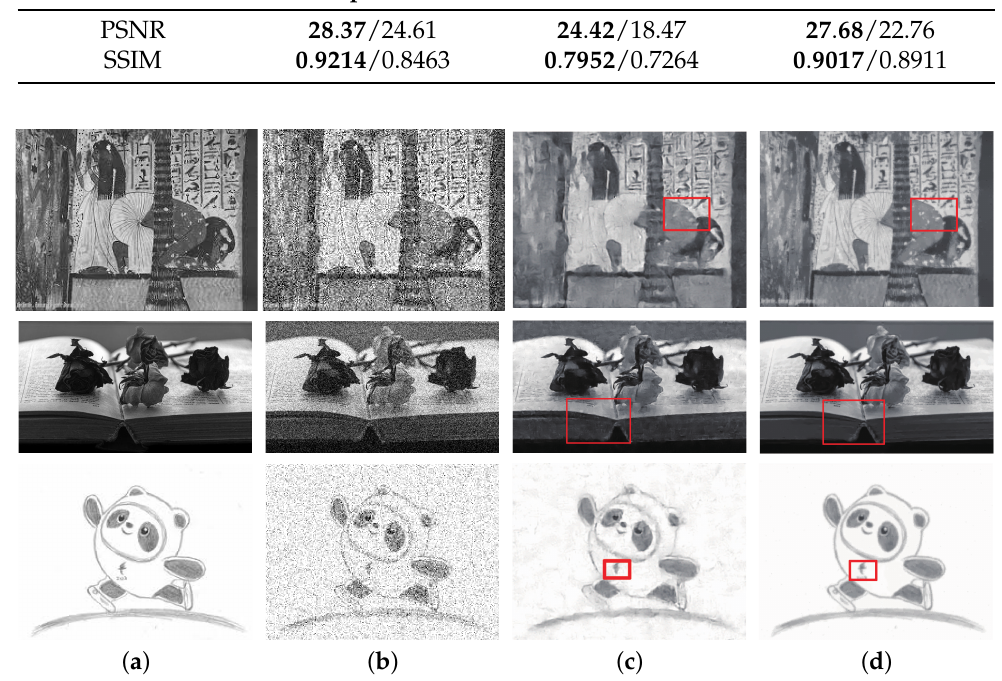
Figure 7. The comparison results between the smoothing results with deep learning image denoising schemes and our proposed method. From top row to the bottom row, the image types are scan- ning image, photo taken by camera, and JPEG compressed image, respectively. ( a ) Ground truth. ( b ) Image with 10% Gaussian noise. ( c ) Results obtained by DcNN. ( d ) Results obtained by our proposed